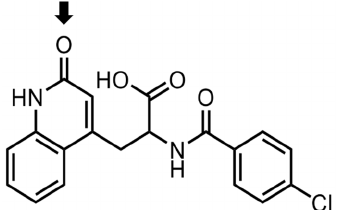
Figure 2. Chemical structural formula of RB. The carbonyl group (black arrow) was the focus of FT-IR.